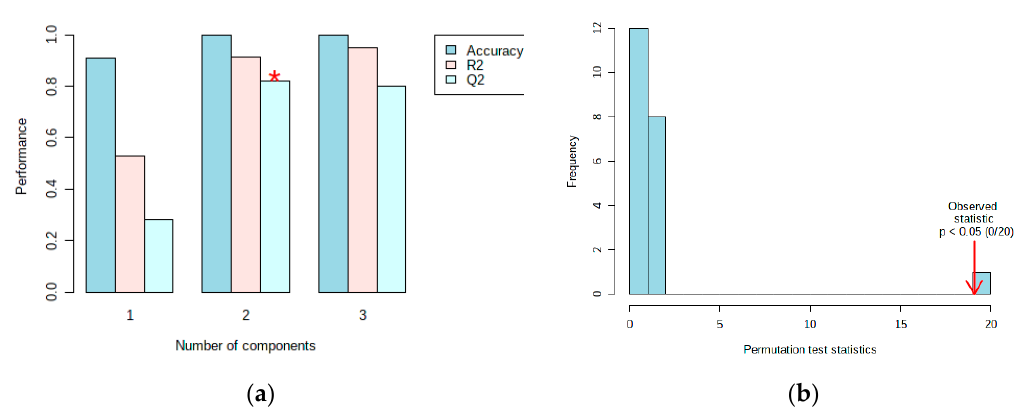
Figure 5. Validation of the PLS-DA model showing the variance of the response and predictive ability of the model ( a ) and a permutation test statistic ( b ). (*) indicates the optimal number of components included in order to make this model work.